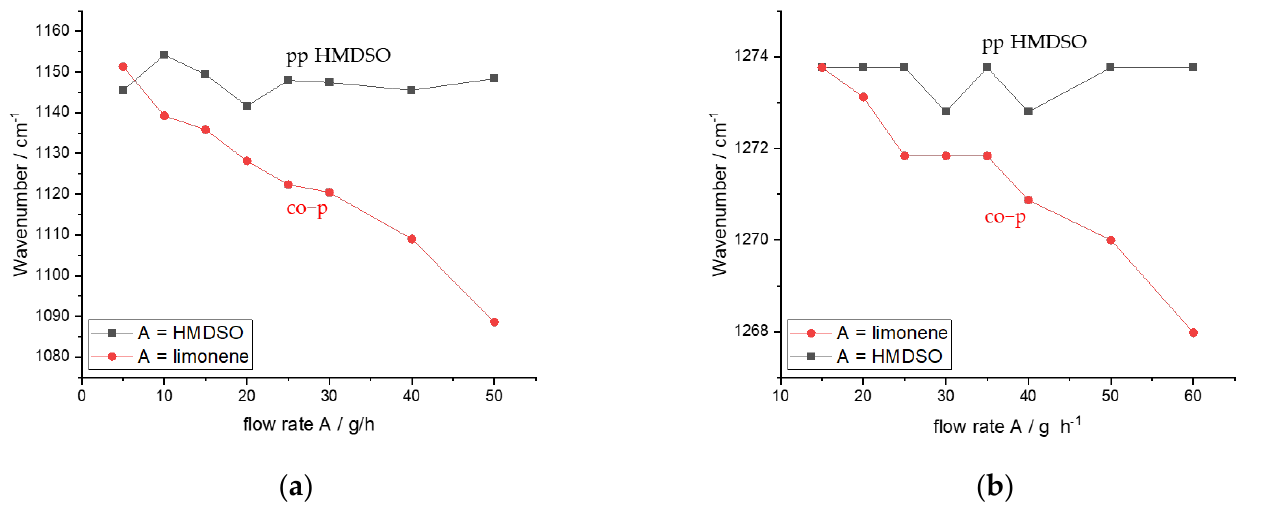
Figure 3. Position of the FTIR absorption maximum of the ( a ) Si-O-Si; ( b ) Si-(CH 3 ) Si-(CH 3 ) x(x=1 – 3) stretching mode of pp HMDSO and co-p. For co- polymerization, the HMDSO flow rate was fixed at 10 g∙h −1